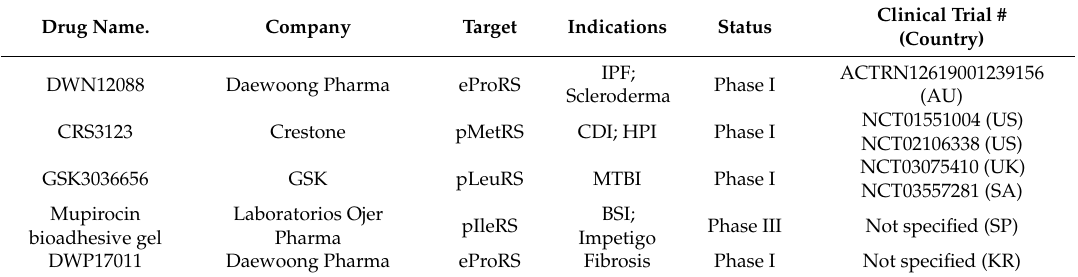
Table 3. A list of small molecules in clinical trials for the development of ARS inhibitors. Drug Name.